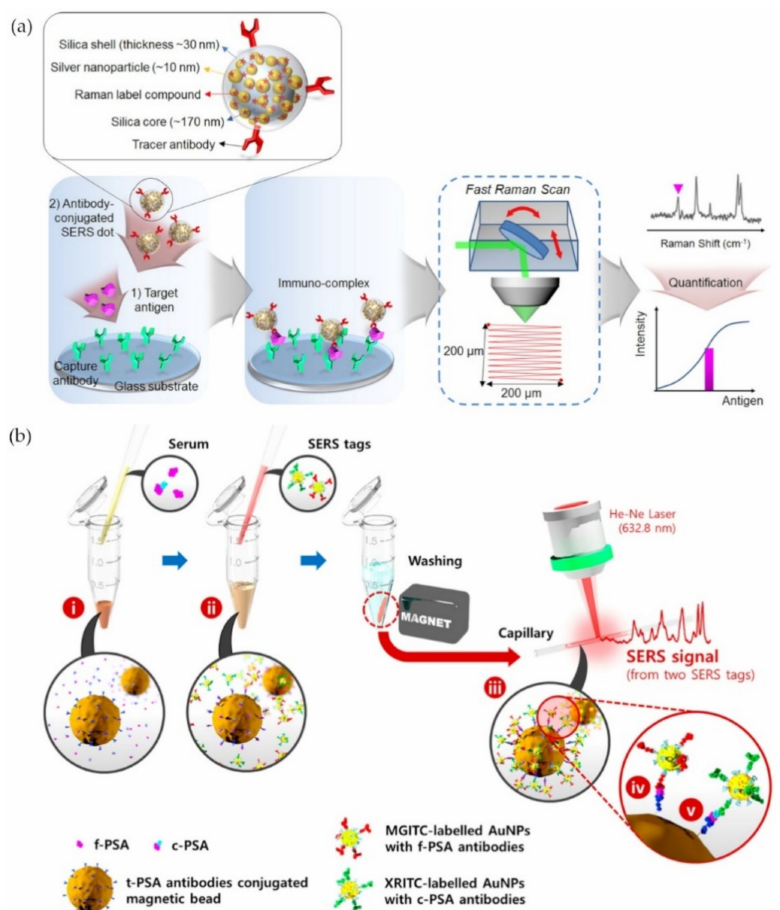
Figure 5. Schematics of surface-enhanced Raman scattering (SERS) assays for the detection of the prostate-specific antigen (PSA): ( a ) Simultaneous detection of free PSA and complexed PSA; ( b ) SERS signal area scanning for PSA detection. (Reproduced with permission from [38], published by American Chemical Society 2016; reproduced with permission from [39], published by American Chemical Society